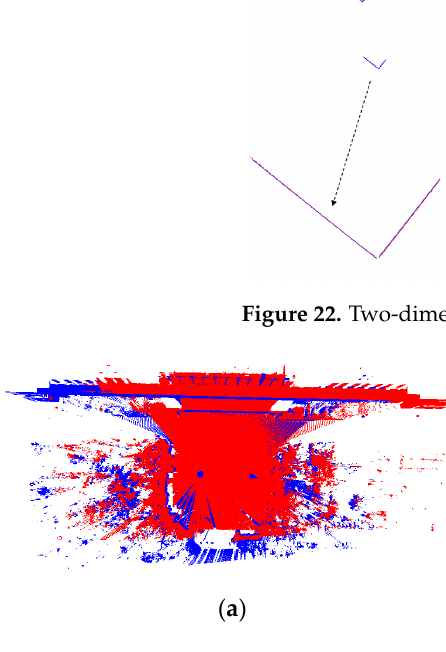
Figure 23. The registered point cloud on the X-Y plane. ( a ) Top view. ( b ) Front view. However, as shown in Figure 23b, the two registered point clouds still have elevation deviation in the Z direction. It is known that the average ground elevation near the scanner of P t and P s is − 175.084 m and − 180.901 m, respectively. The final registration result can be obtained by shifting P s upward by 5.817 m (see Figure 24).